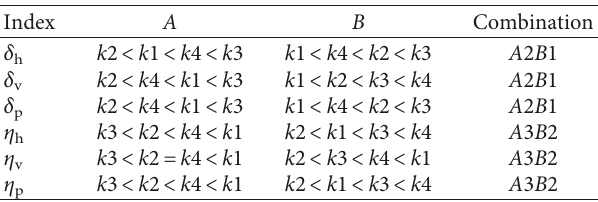
Figure 15: Influence of friction coefficient on cross-sectional distortion during each process. Table 4: Optimal parameter combination of factors A and B in each process.